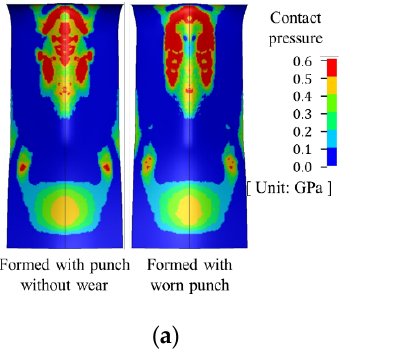
Figure 18. Contact pressure of the product formed with punch geometry without wear and worn punch geometry: ( a ) contour plot of contact pressure, ( b ) quantitative comparison of contact pressure.